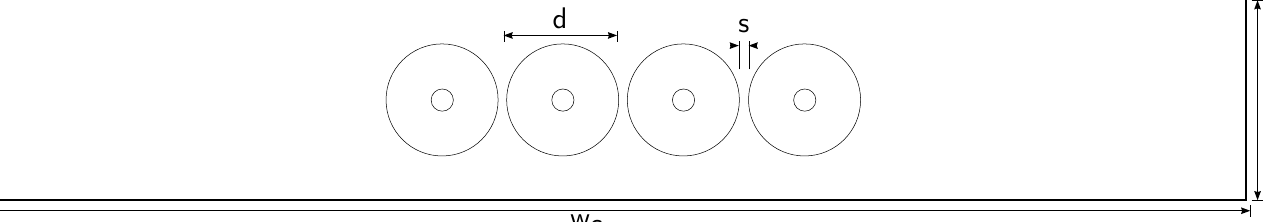
is fixed at 2 d . Two of the cases, Cases 1 and 5, B L = 1 πd 2 /h ( s + d ) = 0 . 0001 and B L = 0 . 1960 respectively, were 4